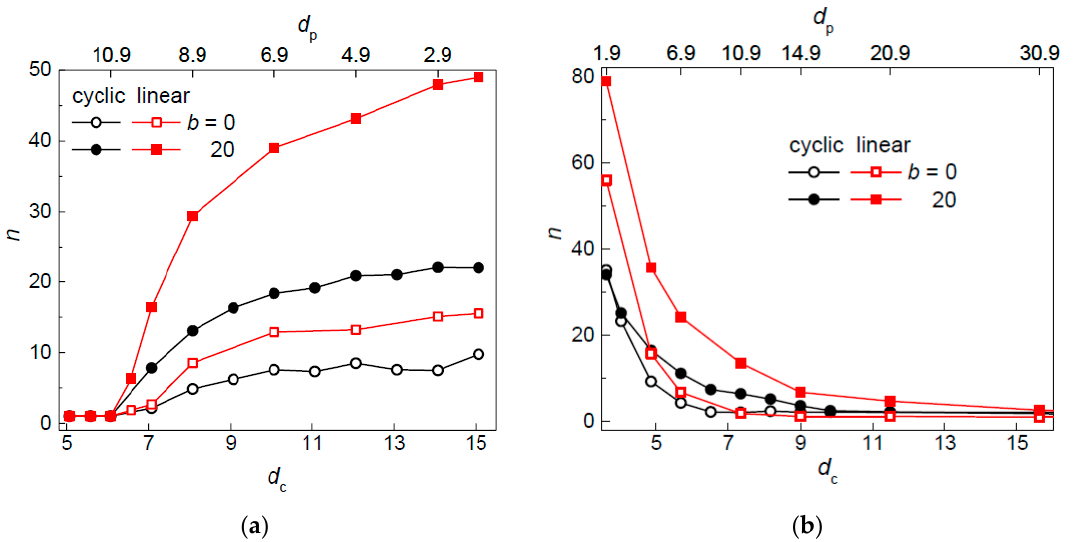
Figure 3. Occupation number of a flexible ( b = 0) and semiflexible ( b = 20) circular and linear chain in an array of posts of varying diameter d p separated by S p = 12 ( a ) and with passage width w p = 2 ( b ) as a function of the size of the interstitial space.